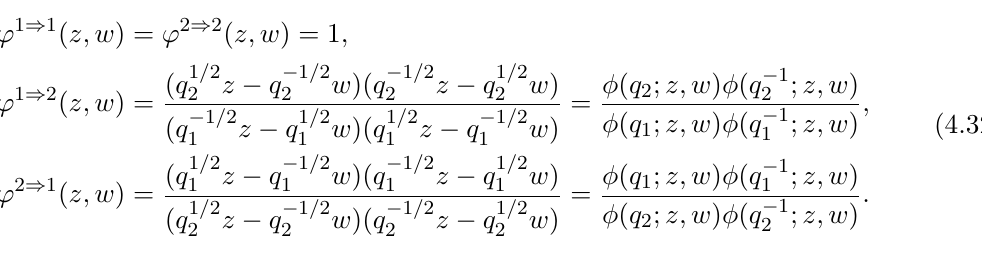
and p so the union set of the perfect matching is 2 4 and β = q − 1 2 1 2